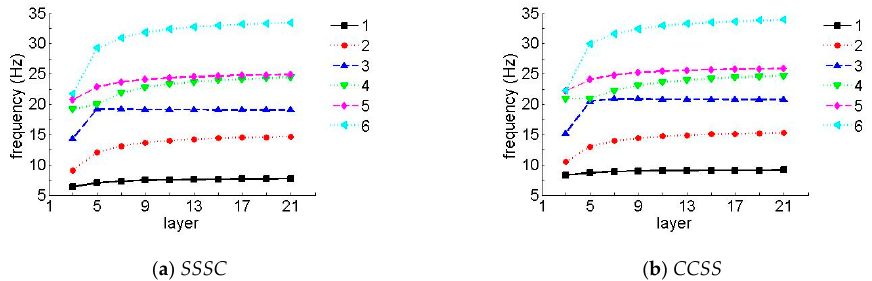
Figure 8. Natural frequency parameters for a laminate with arbitrary layers (laying angle = 45°). ( a ) SSSC, ( b ) CCSS.